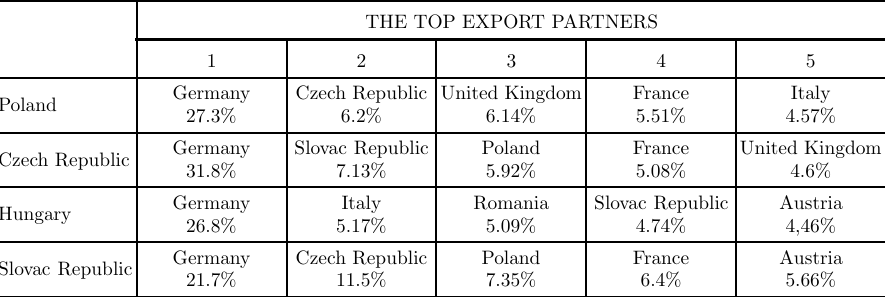
The top export partners of V4, %, share of total export THE TOP EXPORT PARTNERS